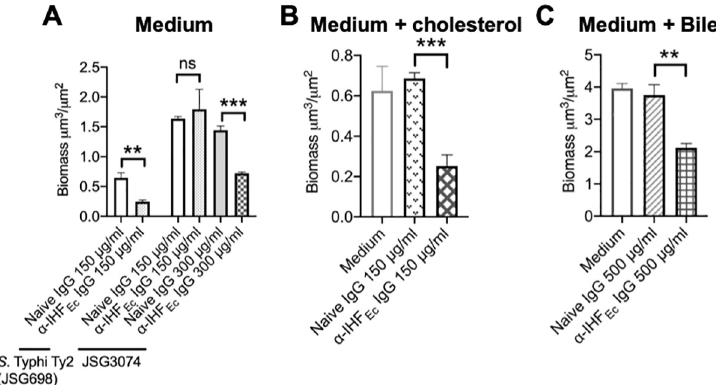
Fig 4. DNABII-specific antibody disrupted biofilms formed by chronic carriage isolate of S . Typhi. ( A ) Biofilms formed by lab wild type strain S . Typhi Ty2 (JSG698) or chronic carriage isolate (JSG3074) or ( B, C ) JSG698 were established in an 8-well chambered coverglass slide in TSB (A), chambered coverglass slide coated with 5 mg/ml cholesterol ( B ), or TSB+0.5% ox bile extract ( C ) for 24 hours. Biofilms were incubated with medium alone, naive IgG, or α -IHF Ec IgG at the indicated concentration for 16 hours. Biofilms were stained with LIVE/DEAD stain and visualized via CLSM. Images were analyzed by COMSTAT to calculate biomass. Bars represent the SEM. �� P < 0.01, ��� P < 0.001 via unpaired t test. Biofilms formed by S . Typhi Ty2 (JSG698) in the presence of cholesterol and bile, as well as a chronic carriage isolate of S . Typhi, were significantly disrupted by DNABII-specific antibody ( α -IHF Ec ).